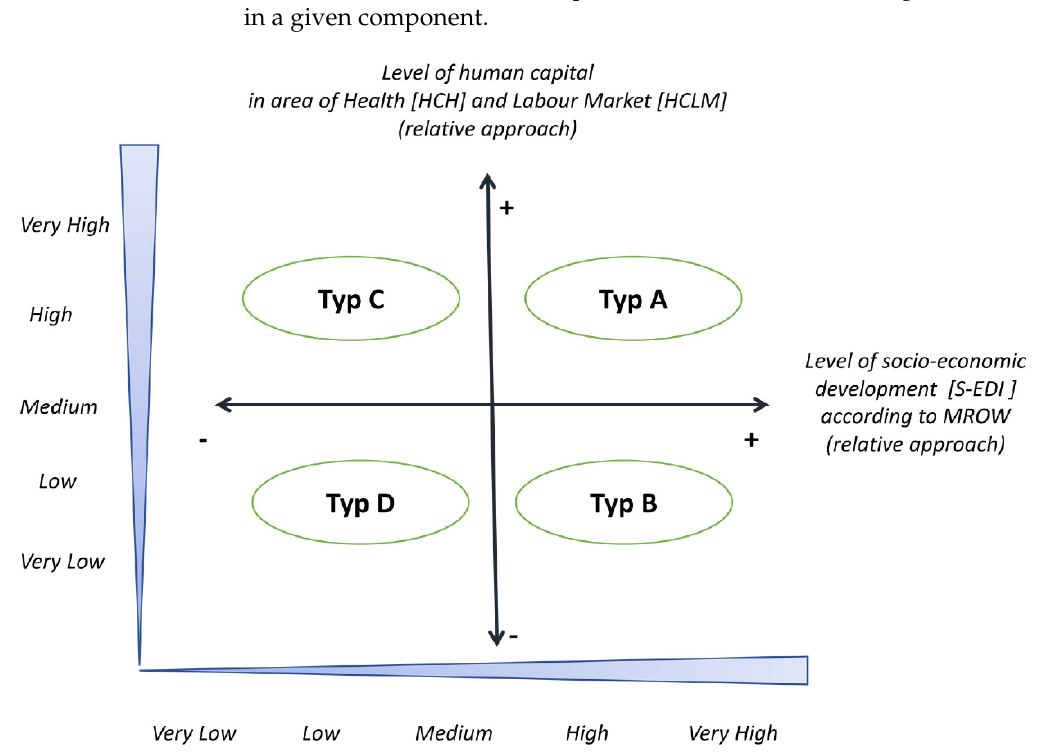
Figure 3. The linkage between the level of human capital (HCH/HCLM) and the level of socio-economic development (S-EDI) in rural areas. The effects of communes’ positioning. Source: Own elaboration.